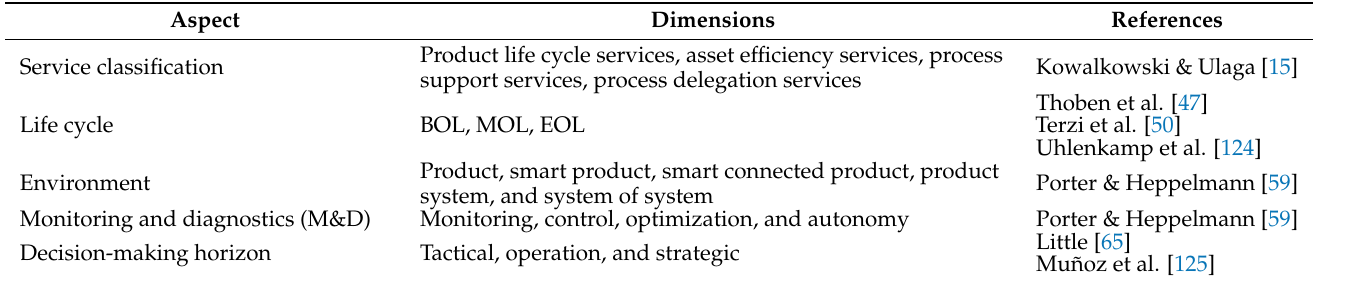
Table 1. Data collated to support the categorization of the digital twin use cases.